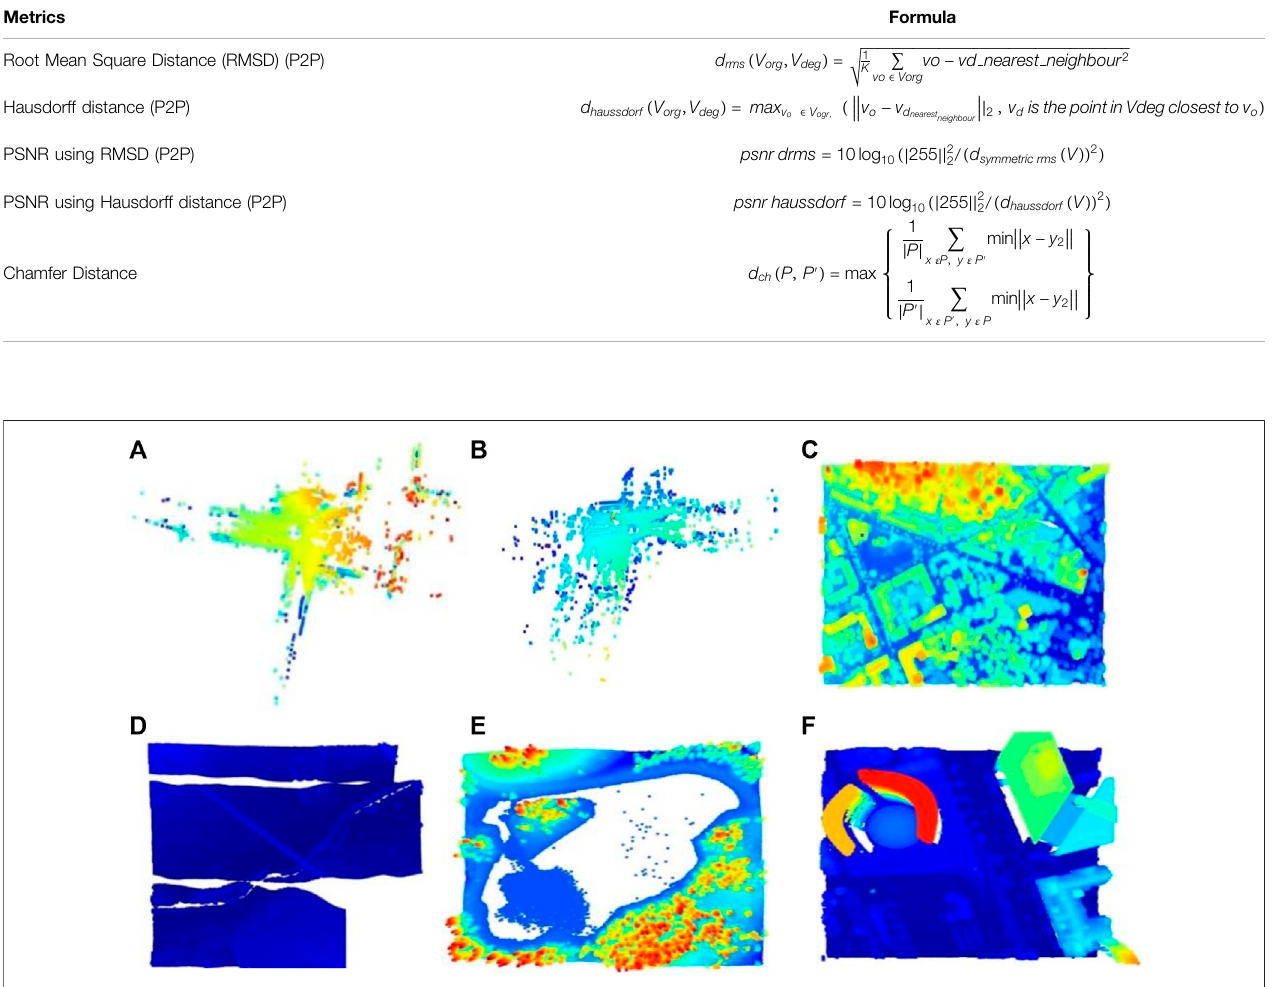
Frontiers in Robotics and AI |